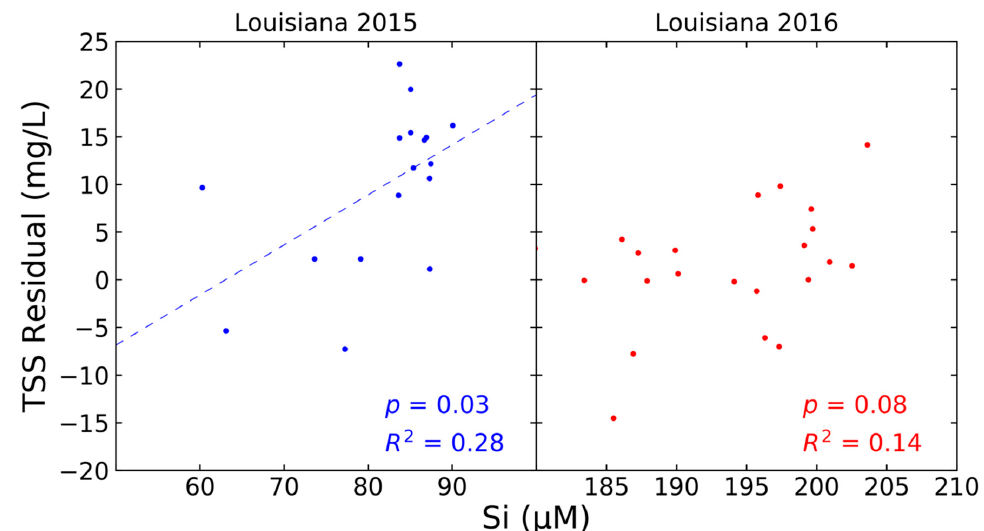
Figure A2. Statistical relationships between predicted TSS residuals and silicate (micromolar) for the 2015 and 2016 Louisiana in situ validation datasets. Silicate here serves as a proxy for particulate inorganic matter. The regression line is plotted for the 2015 data’s relationships that is significant at a p < 0.05 level.